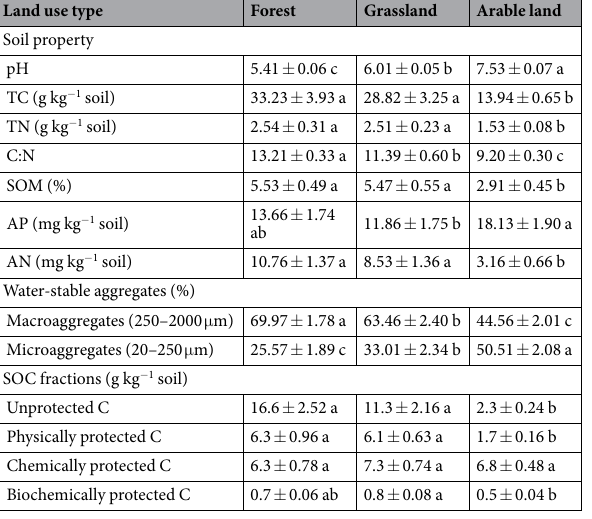
Table 1. Chemical properties, proportions of water-stable aggregates, SOC and N stock and four SOC fractions in soils of different land use types. Data are mean ± SE (n = 15). Means followed by the same letter do not differ significantly at P ≤ 0.05 by Duncan’s multiple range